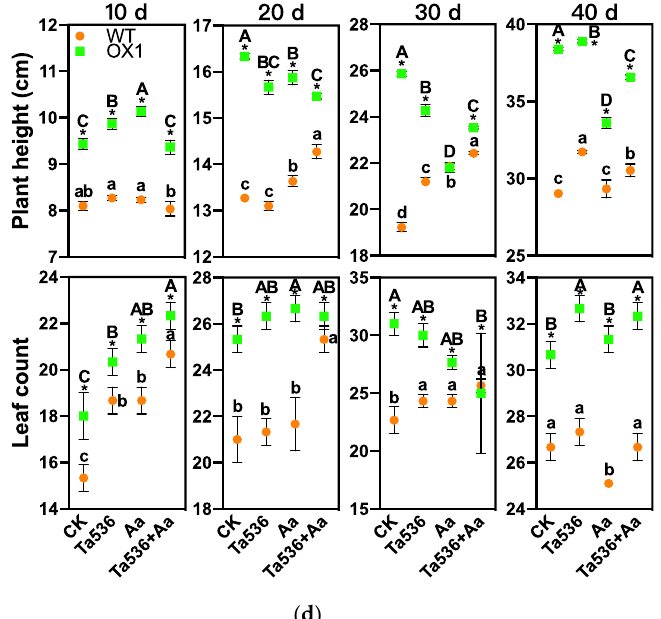
Figure 2. The identification, phenotypes, and growth traits of transformed poplar plants. ( a ) The relative expression of PdPapARF1 in the transgenic plant lines determined by qRT-PCR. Data were achieved from three technical replicates. ( b ) Three-week-old subcultured poplar plants in 8 cm (bottom diameter) vessels. The two upper panels show the plants and the two lower panels show their roots. ( c ) Three-week-old poplar plants in 3.5 cm (bottom diameter) vessels showing an evident increase of adventitious roots of the OX1 plants. ( d ) Growth dynamics of the WT and OX1 plants undergone different 48-h-treatments (see methods for details), then grew in pot soil for 40 days. d, day(s). Data on 0 days did not have any significant difference between the groups; thus, those data are not shown. For each group and each treatment, n = 3. ( e ) The total amount of adventitious roots (AR) per plant (AR count, n = 8) and the total amount of lateral root (LR) per AR (LR count, n = 4). Different capital letters represent significant differences among the OX plants treated with different inoculations; different lowercase letters represent significant differences among the WT plants treated with different inoculations; * significant difference between OX and WT plants undergone the same inoculation. All significances were at p < 0.05.